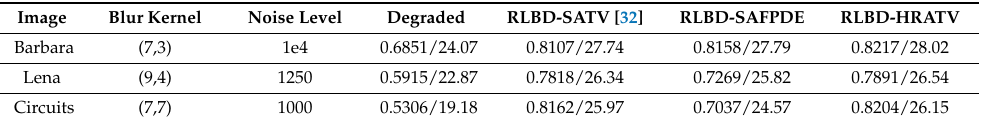
Table 1. Structural Similarity Index Measure (SSIM)/ peak signal-to-noise ratio (PSNR) comparisons of three deconvolution